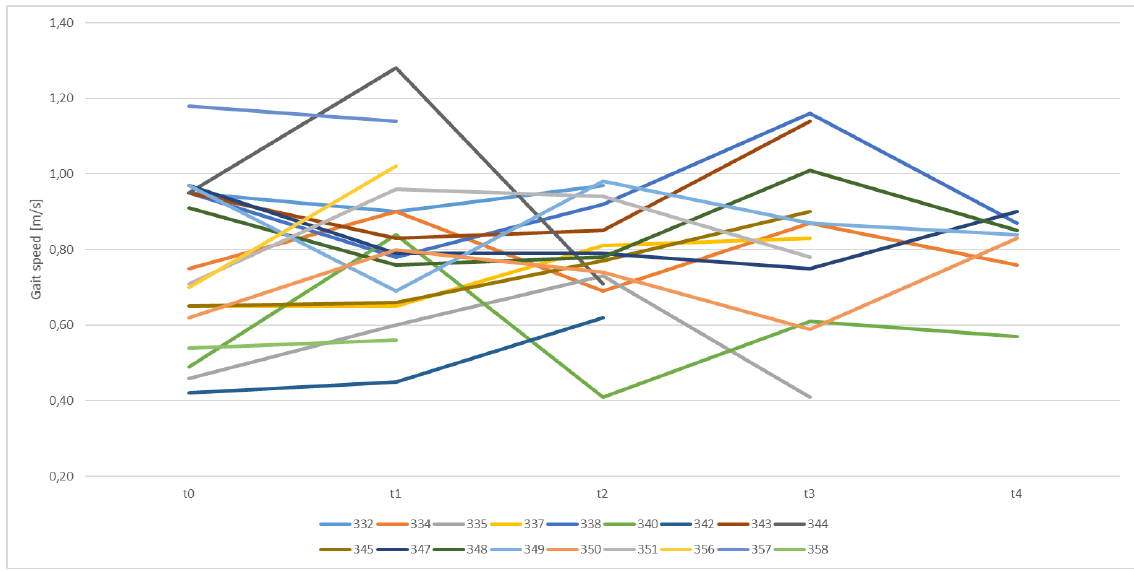
Figure 4: Comparison of methods assessing gait speed. The measurements of physiotherapists as well as the tracker follow the change of the ground truth data. The blue and orange lines illustrate the deviation from the ground truth.